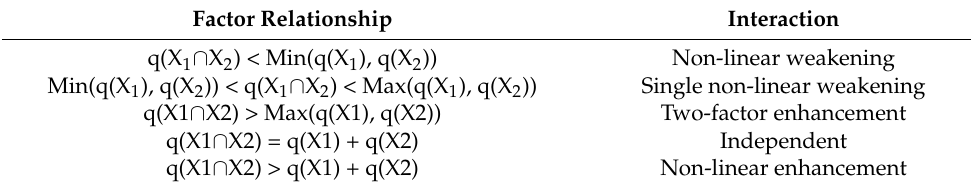
Table 1. The relationships of factors in the interaction